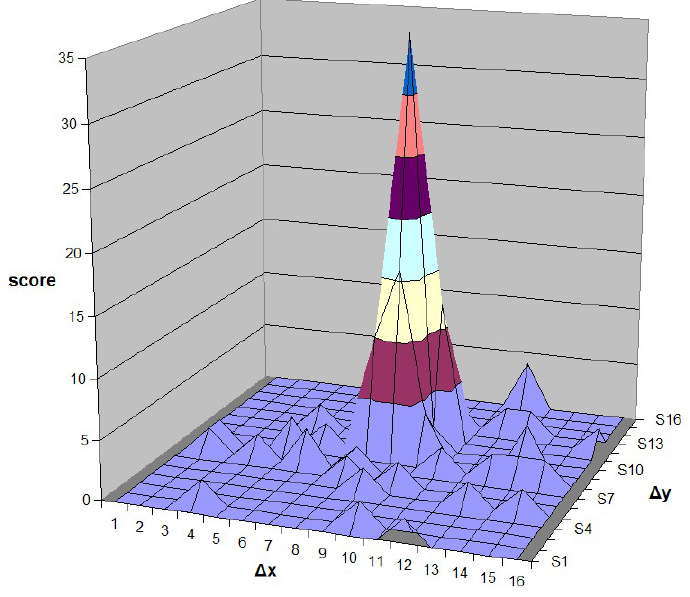
Figure 8. Distributions of small 2-D accumulator array in the second